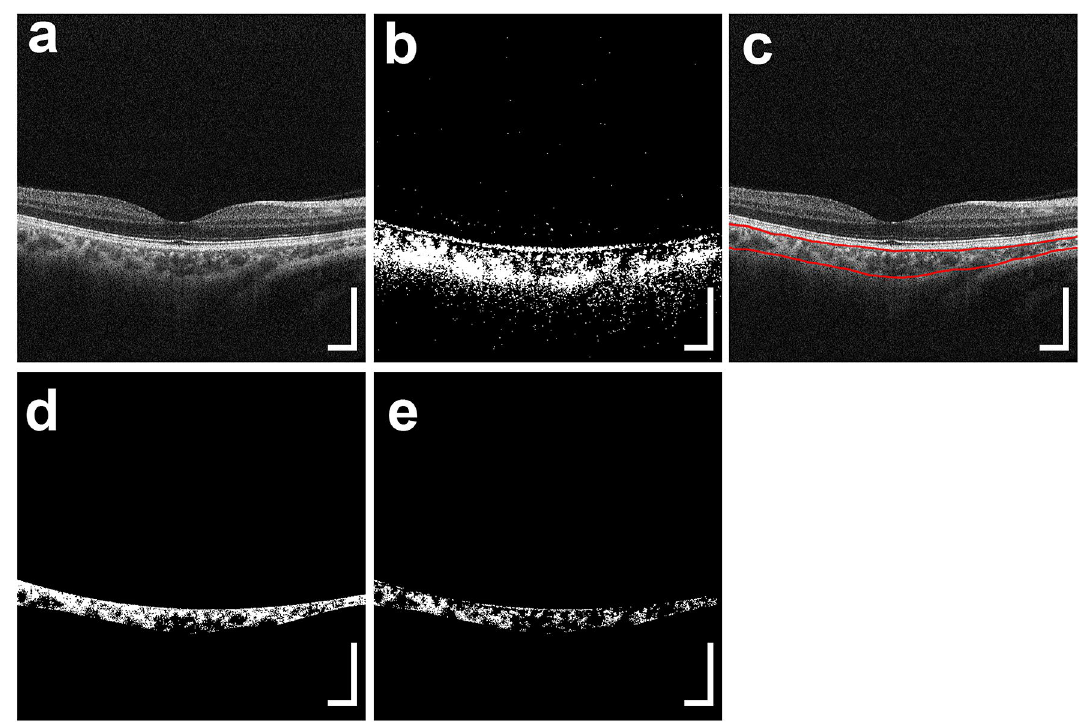
Figure 1. PS-OCT imaging of the right eye of a 48-year-old man. ( a ) Standard OCT B-scan image. ( b ) Binary DOPU B-scan image (DOPU of < 0.8). ( c ) Red lines in the standard OCT B-scan image represent the boundaries for automatic selection of the choroid area. ( d ) Binary B-scan image of choroidal interstitial stroma. ( e ) Binary B-scan image of a low-DOPU area (< 0.8) within the choroidal interstitial stroma. The scale bars represent 500 μm × 500